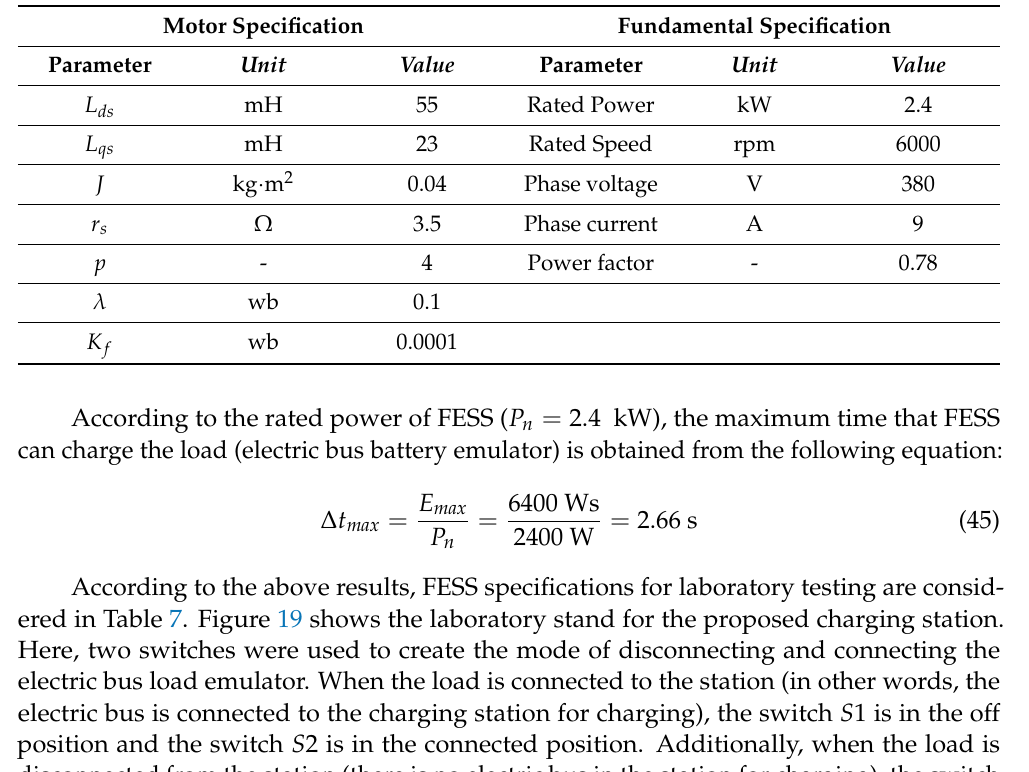
Table 6. Parameter values of FESS.